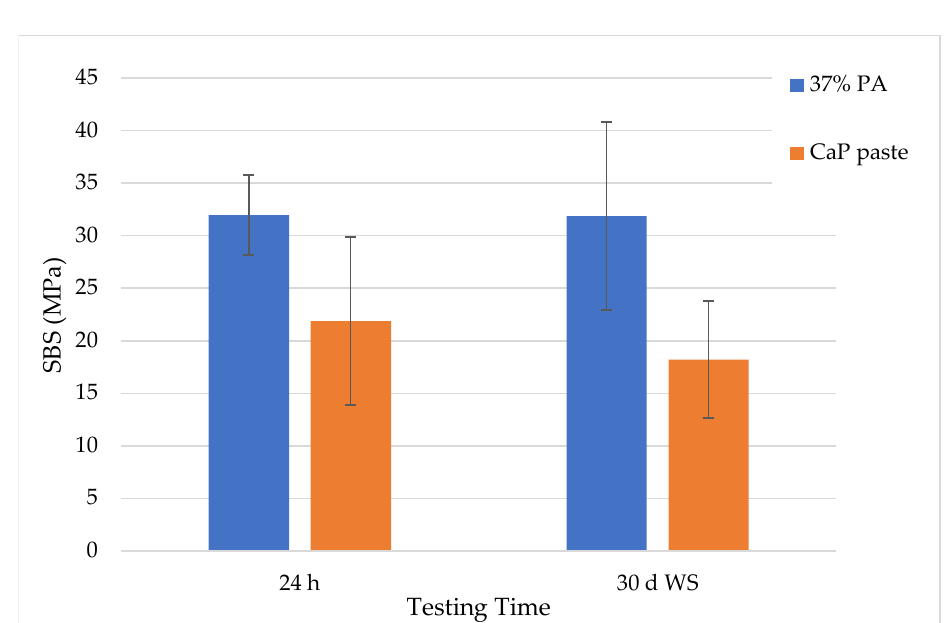
Figure 1: Bar chart illustrating SBS values for all subgroups according to testing